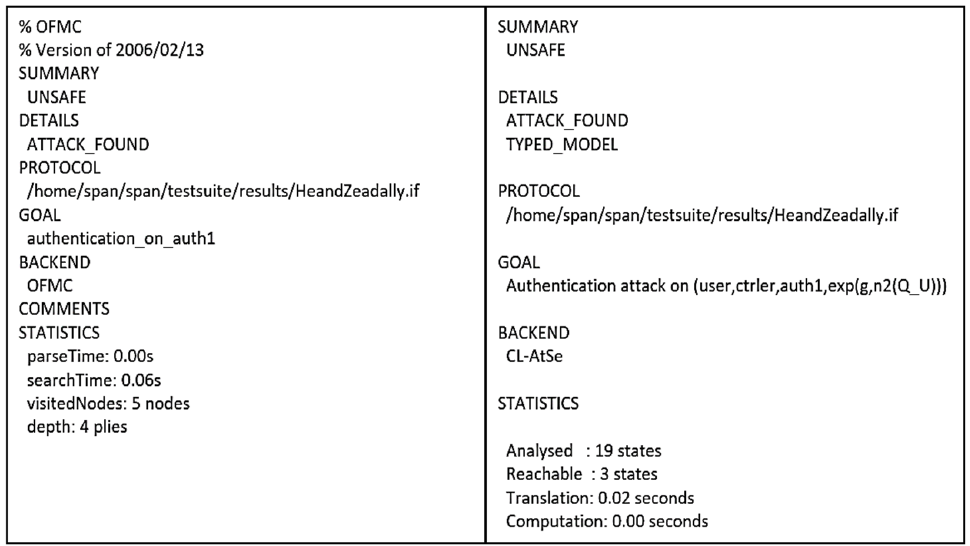
Figure 15. AVISPA result of He and Zeadally’s protocol.